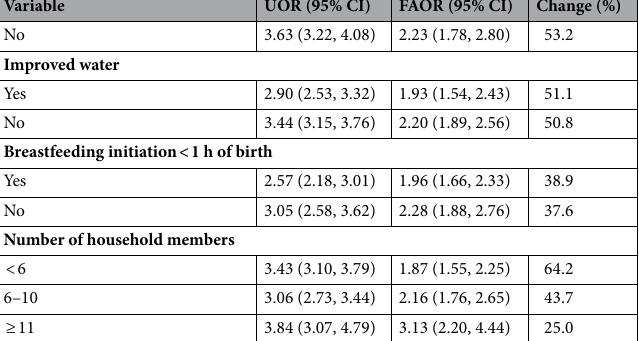
Table 2. Unadjusted odds ratio (UOR) and fully adjusted odds ratios (FAOR) for neonatal mortality by maternal history of neonatal death, pooled sample and subgroup samples. (1) “Change” is the degree to which the odds ratios were attenuated after adjustment that was calculated according to the formula